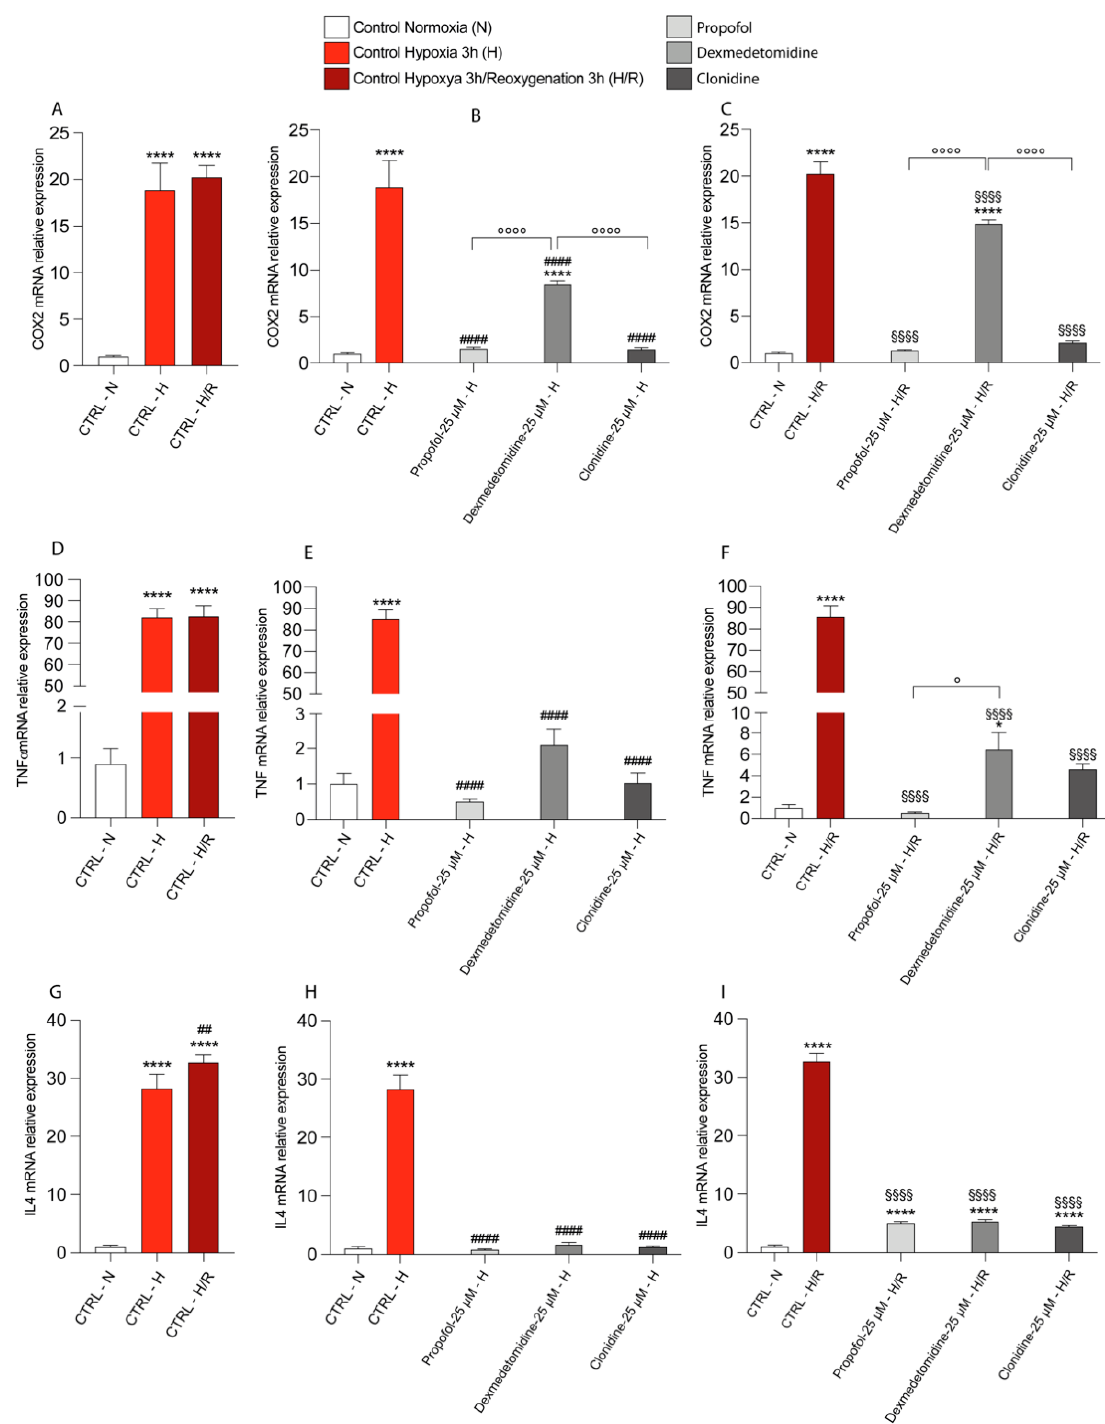
Figure 4. Effect of Hypoxia and Reoxygenation and pharmacological treatments on mRNA expression of COX2 ( A – C ), TNF ( D – F ), IL4 ( G – I ), performed by Real-time PCR. The calculated value of 2 −ΔΔ Ct in untreated controls is 1. Data are expressed as mean ± SD of at least four independent experiments. * vs. CTRL Normoxia (* p < 0.05; **** p < 0.0001); # vs. CTRL Hypoxia ( ## p < 0.005; #### p < 0.0001); § vs. CTRL Hypoxya/reoxygenation ( §§§§ p < 0.0001); ° vs. the different drugs (propofol vs. dexmedetomidine; propofol vs. clonidine; dexmedetomidine vs. clonidine) (° p < 0.05; °°°° p < 0.0001).